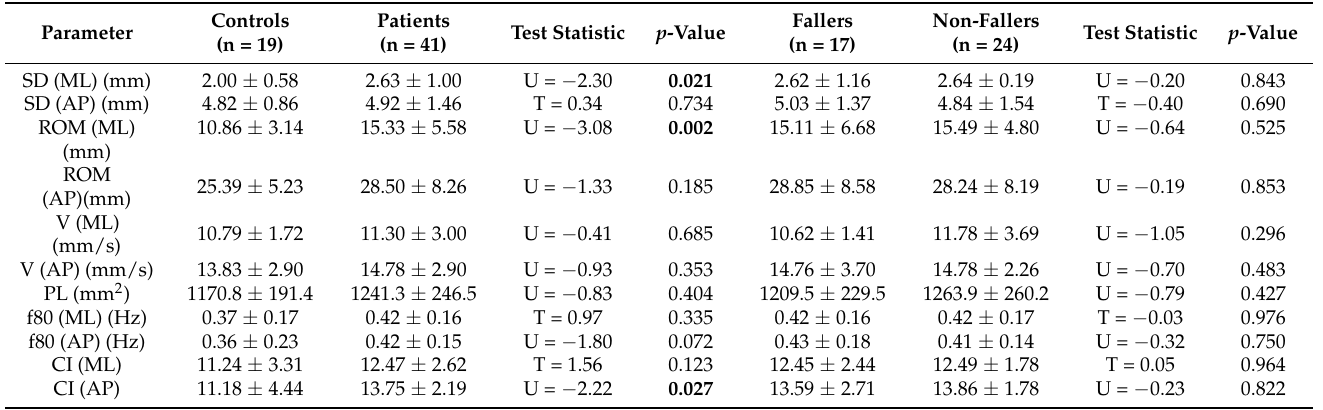
Table 2. Mean ± standard deviation of center-of-pressure parameters for controls and patients (women with osteoporosis), as well as for osteoporotic women with (fallers) and without (non-fallers) a fall incident. Corresponding test statistics ( t -test or Mann–Whitney U-test) and p -values are presented for patients vs. controls and fallers vs. non-fallers.